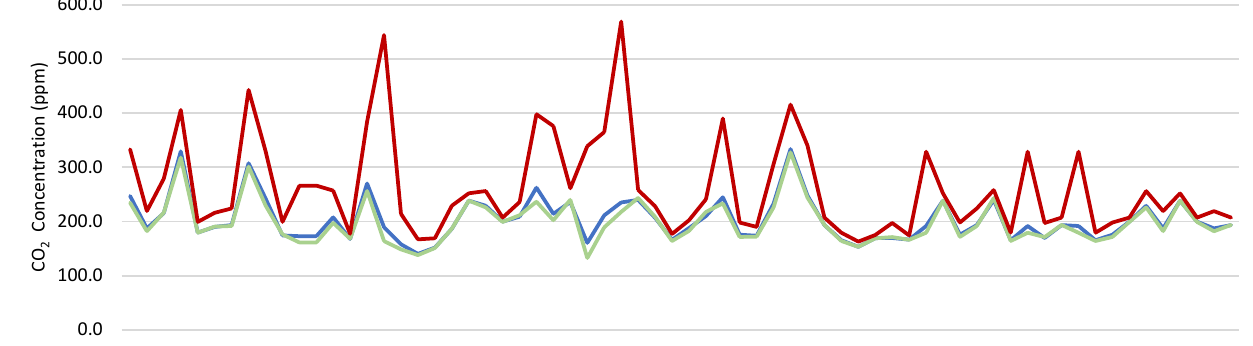
Figure 1. CO 2 concentration (ppm) indoors.